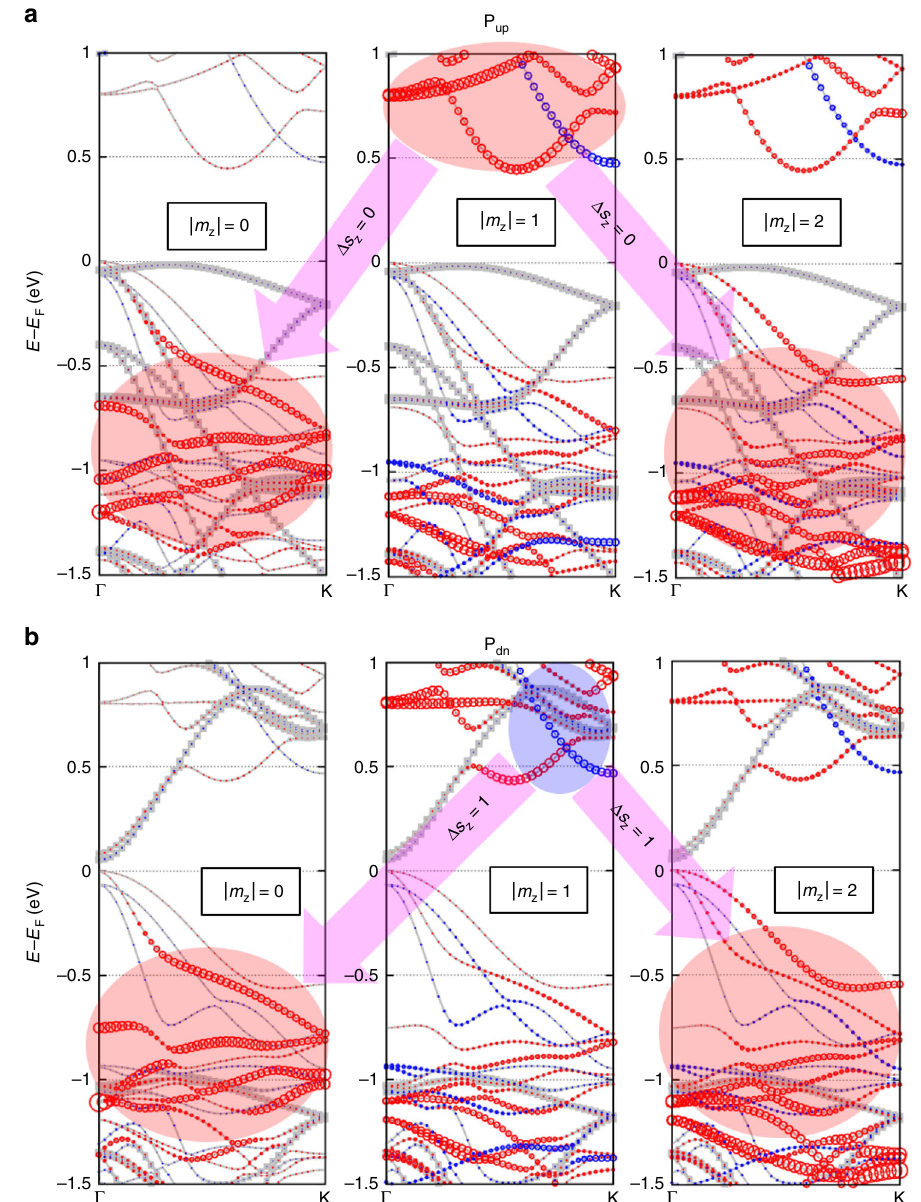
Fig. 2 Spin-polarized and Cr d orbital-decomposed band structures of Cr 2 Ge 2 Te 6 /In 2 Se 3 heterostructures. a , b The calculated band structures for the heterostructures with P up and P dn In 2 Se 3 , respectively. For each electric polarization, the heterostructure (in terms of contact registry and interlayer distance) adopted the con fi guration of global energy minimum (see Supplementary Fig. 1). The majority and minority spin states are indicated by the red and blue circles, respectively, whose size denotes the contribution of Cr d orbitals with certain azimuthal angular momentum | m z |. In 2 Se 3 states are shown by the gray dots, and the band exhibits the overall shift down by ~1 eV while changing In 2 Se 3 from P up and P dn , which indicates a strong In 2 Se 3 -polarization dependent interfacial coupling. The pink arrows indicate the SOC elements between empty and fi lled states, indicated by the red circle for the majority spin or blue for minority, causing the negative or positive value of MAE (see Eq. (1) and text) for ( a ) or ( b ), respectively, thus the easy-plane or easy-axis S